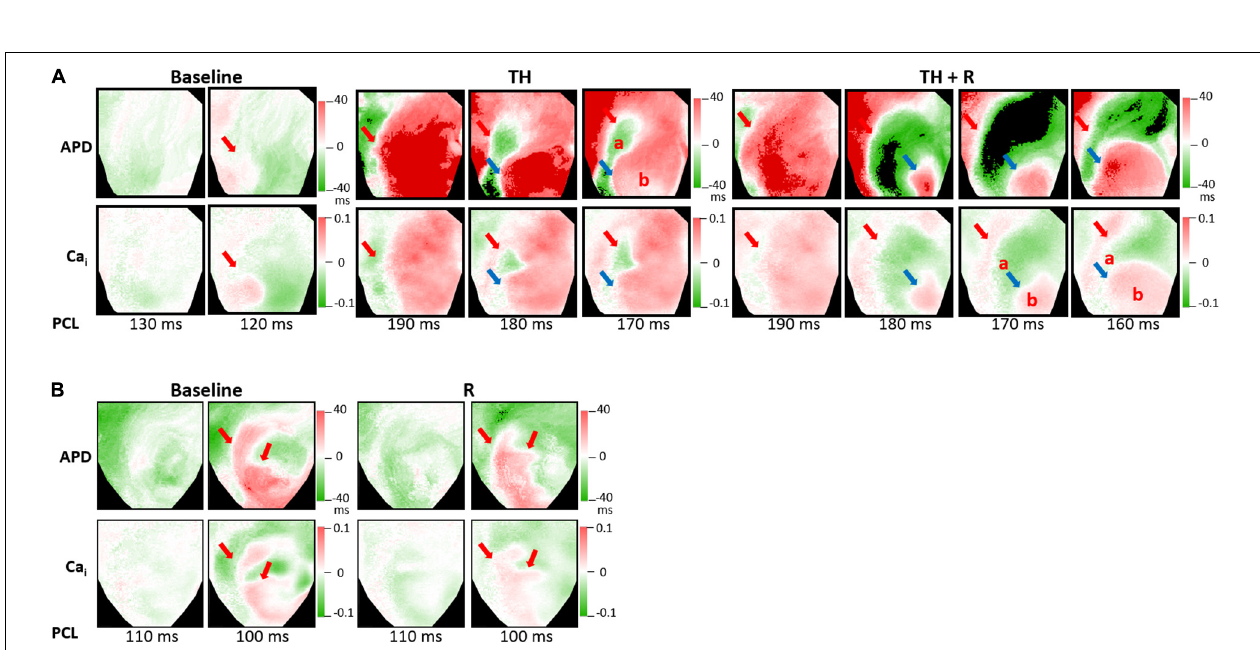
FIGURE 6 | Effects of therapeutic hypothermia (TH) and rotigaptide (R) on spatially discordant alternans (SDA) induction by dynamic pacing. (A) Representative examples of action potential duration (APD) and intracellular Ca 2 + (Ca i ) alternans maps in the TH group. TH enhanced SDA. The second nodal line gradually moved to the border of the IR zone when the heart was paced at a shorter pacing cycle length (PCL). Red and blue arrows indicate the first and second nodal lines. (B) Representative examples of APD and intracellular Ca i alternans maps in the non-TH group.